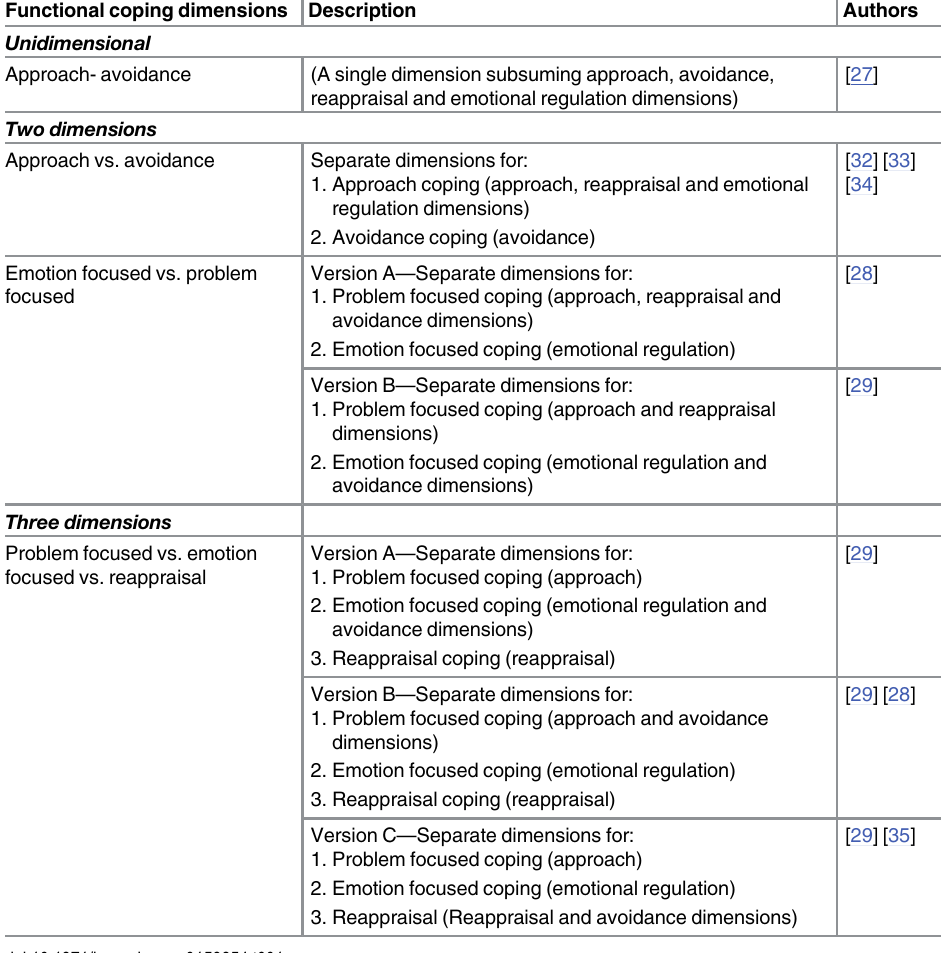
Table 1. The relationships between the four functional coping dynamics outlined by Cox and Fergu- son [25] and alternative conceptualisations of functional coping. Table adapted from Ferguson and Cox